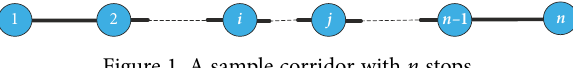
Figure 1. A sample corridor with n stops Table 1. A basic fare structure table for the corridor in Figure